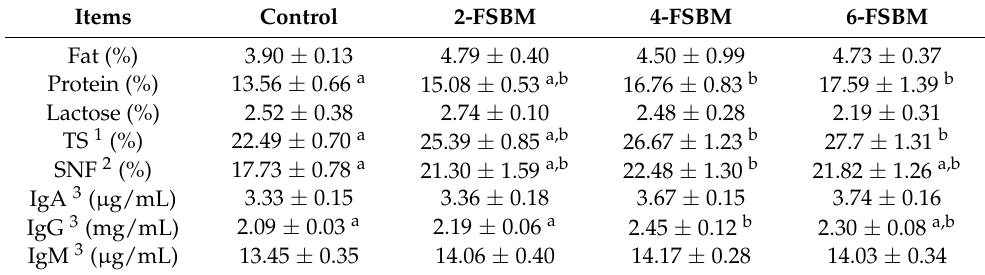
Table 6. The composition and immunoglobulin levels of colostrum from different dietary groups.